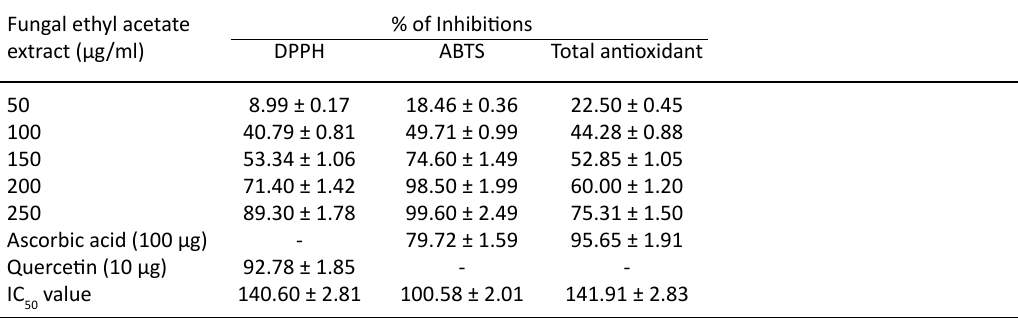
Table 1. Antioxidant activities of M. karstenii Fungal ethyl acetate % of Inhibitions extract